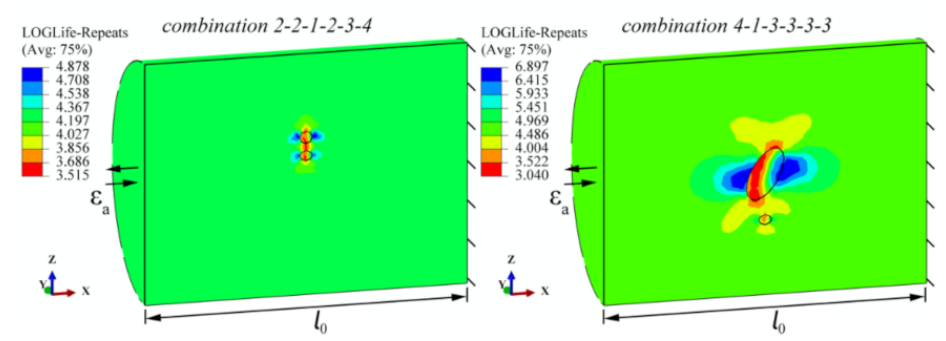
Figure 10. Two examples of numerical calculations of fatigue lives (in LOGLife form) for the combi- nations of influences 2-2-1-2-3-4 and